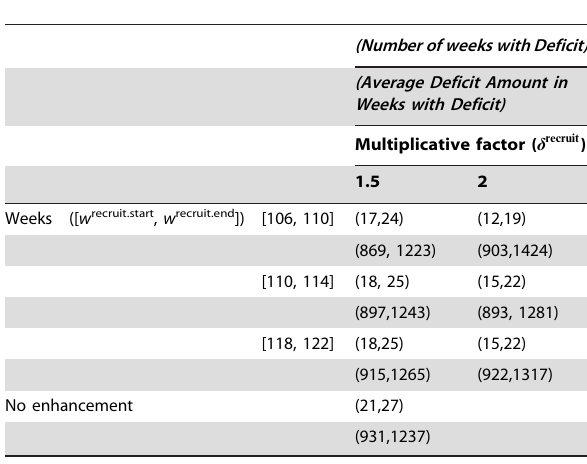
Table 3. Number of Weeks with Deficit (top) and Average Deficit Amount in Weeks with Deficit (bottom) for different recruitment strategies in respose to a moderate supply shock (Weeks 110 – 118 ) and demand spike (Weeks 126 – 138